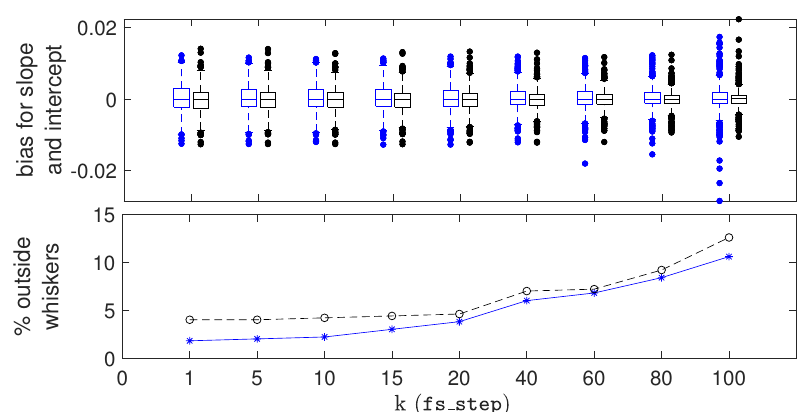
Figure 7. Top panel: boxplots showing, for different values of k (the fs_step parameter, on the x axis), the bias and dispersion of the estimated slopes and intercepts (respectively from left to right for each k ). The estimates are obtained from 500 simulated datasets of 5150 observations; Bottom panel: percentage of estimated values lying outside the boxplot whiskers for slope (blue asterisks) and intercept (black